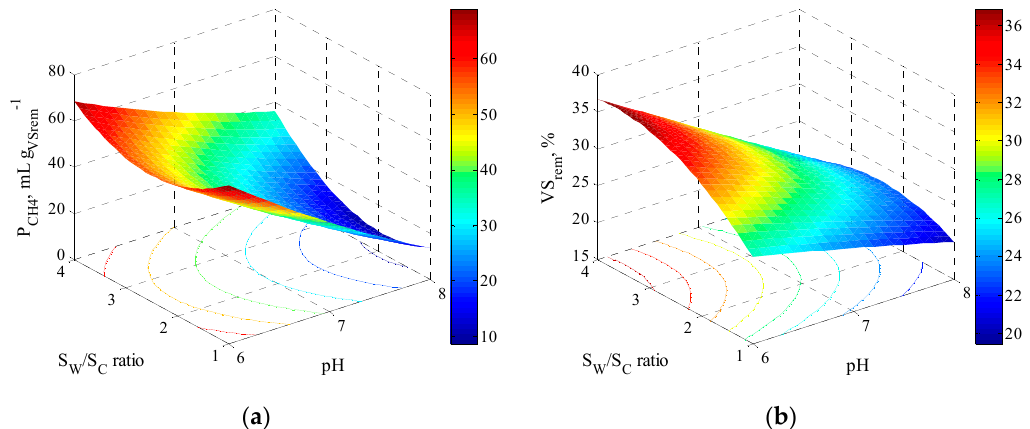
Figure 2. Response surface plot during anaerobic co-digestion of raw cheese whey and coffee pulp with respect to pH and substrate ratio, ( a ) methane production, and ( b ) volatile solids removed.